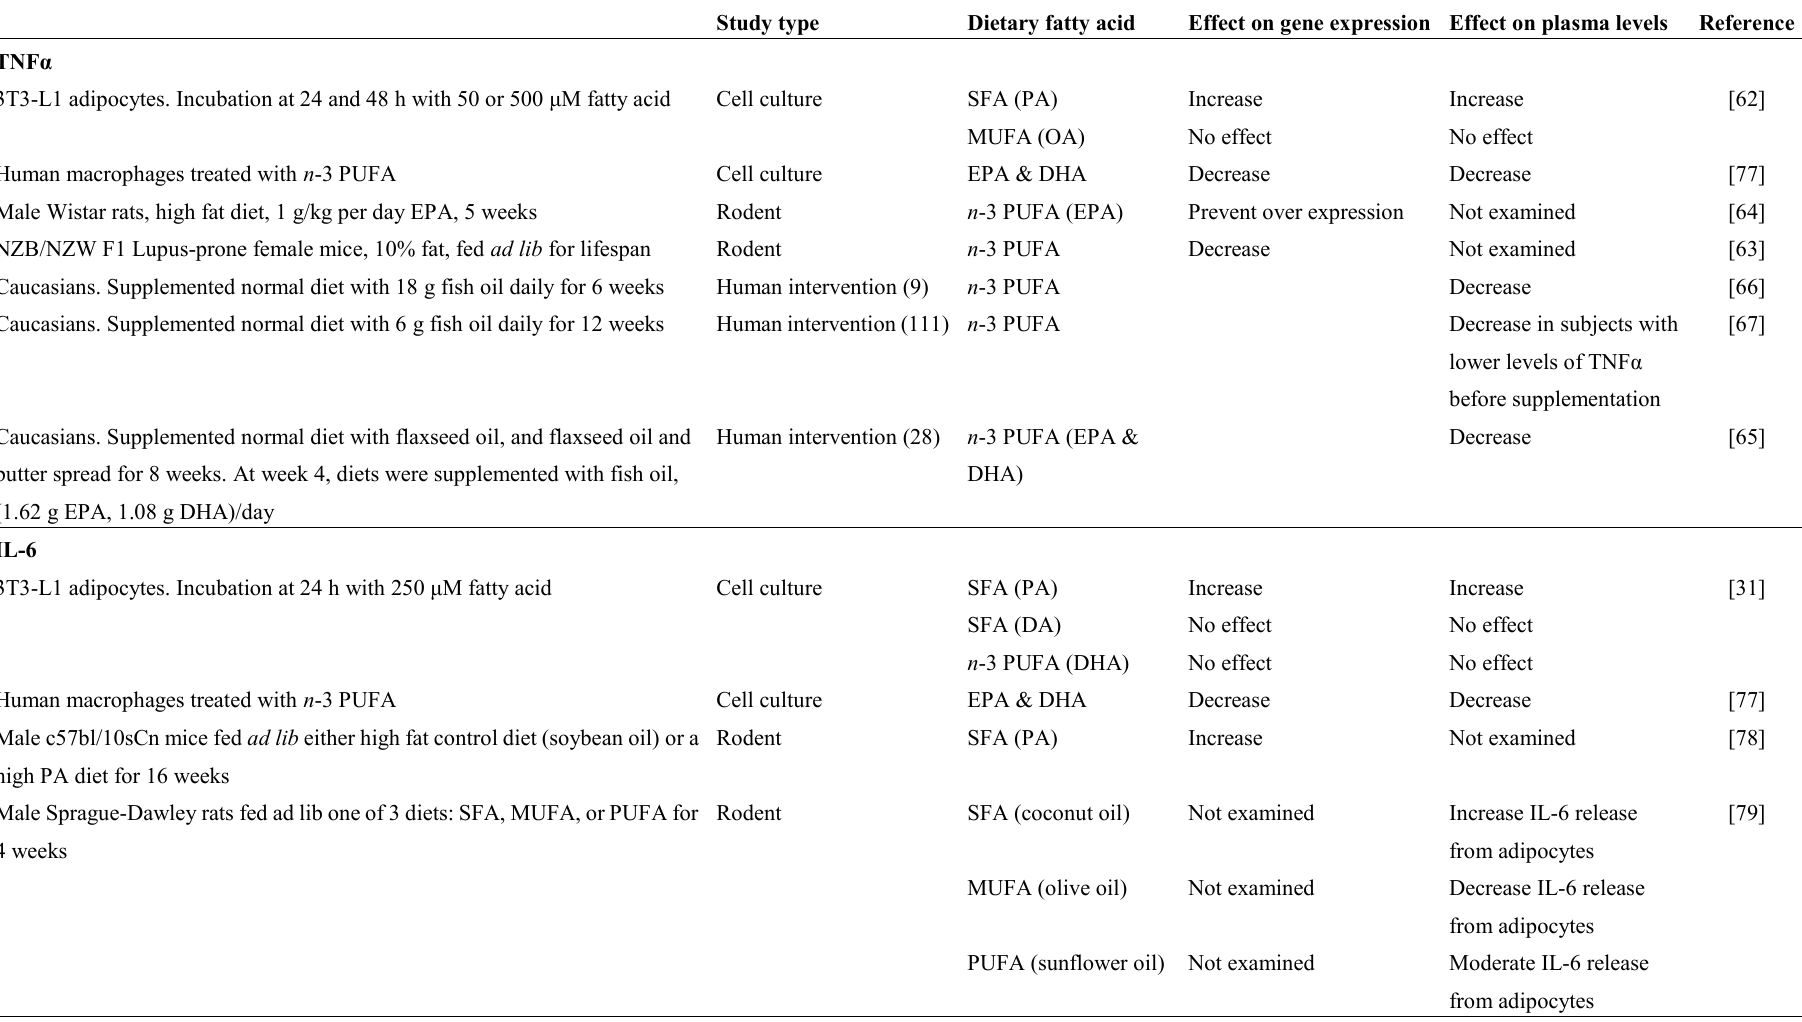
Table 1. Dietary fatty acids and TNFα and IL-6